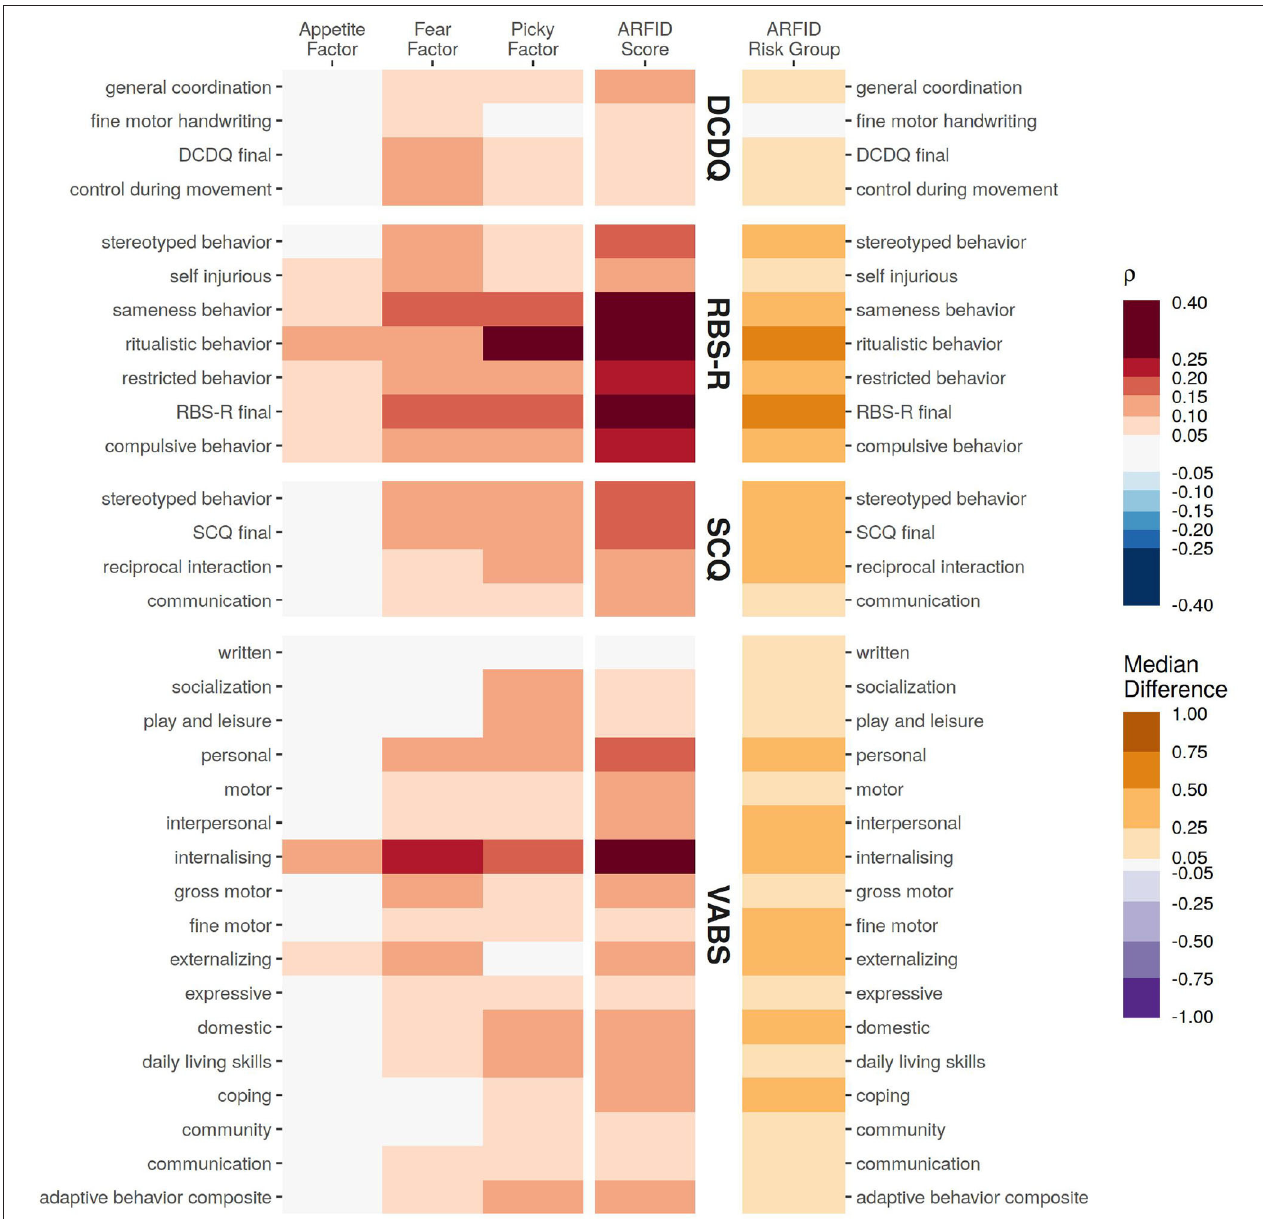
FIGURE 2 | The association of various assessments from the probands with the NIAS factors and ARFID Score, quantified as Spearman correlation coefficient. For differences for those identified as high risk for ARFID (ARFID Risk Group), the association is quantified as the median difference (location shift) from a Wilcox rank-sum